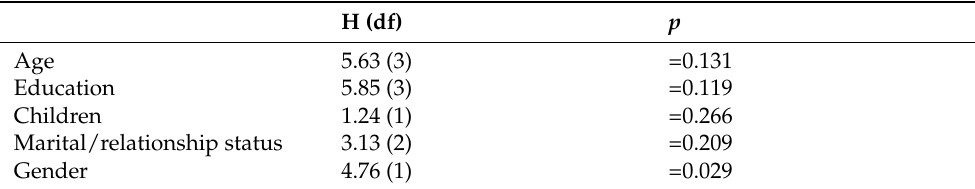
Table 4. Kruskal–Wallis test results assessing the association between GAPS-D scores and owner demographics ( n =